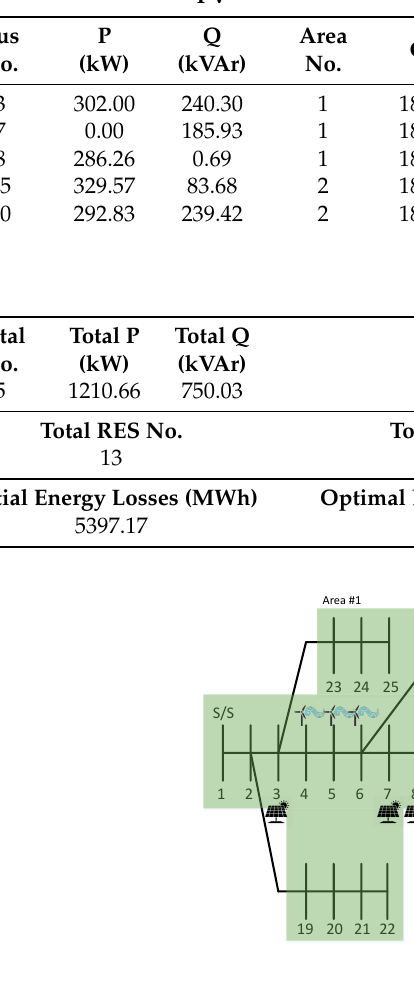
Figure 15. Detailed Analysis—Scenario #3